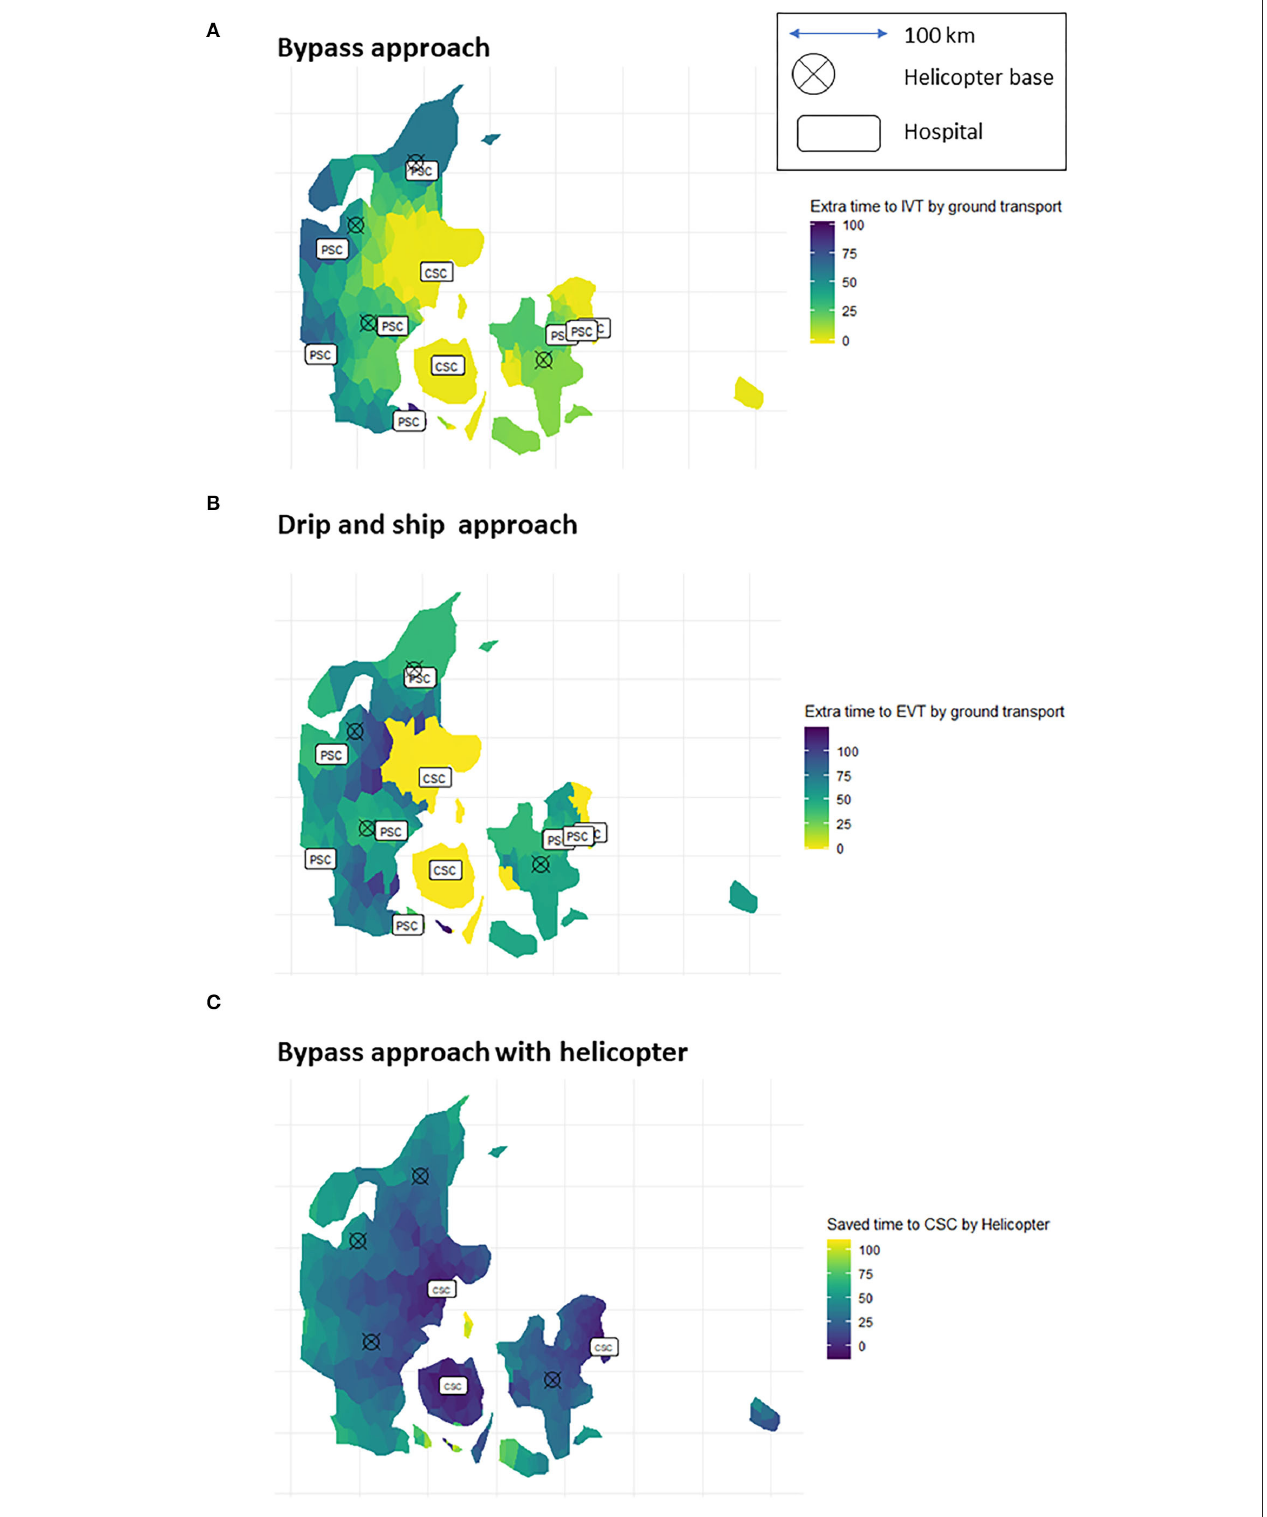
FIGURE 2 | Additional time to intravenous thrombolysis (IVT) with bypass approach (A) and additional time to IVT with the drip and ship approach (B). Time saved to revascularisation therapy at a CSC when using the helicopter (C). The brighter colors the shorter delays.